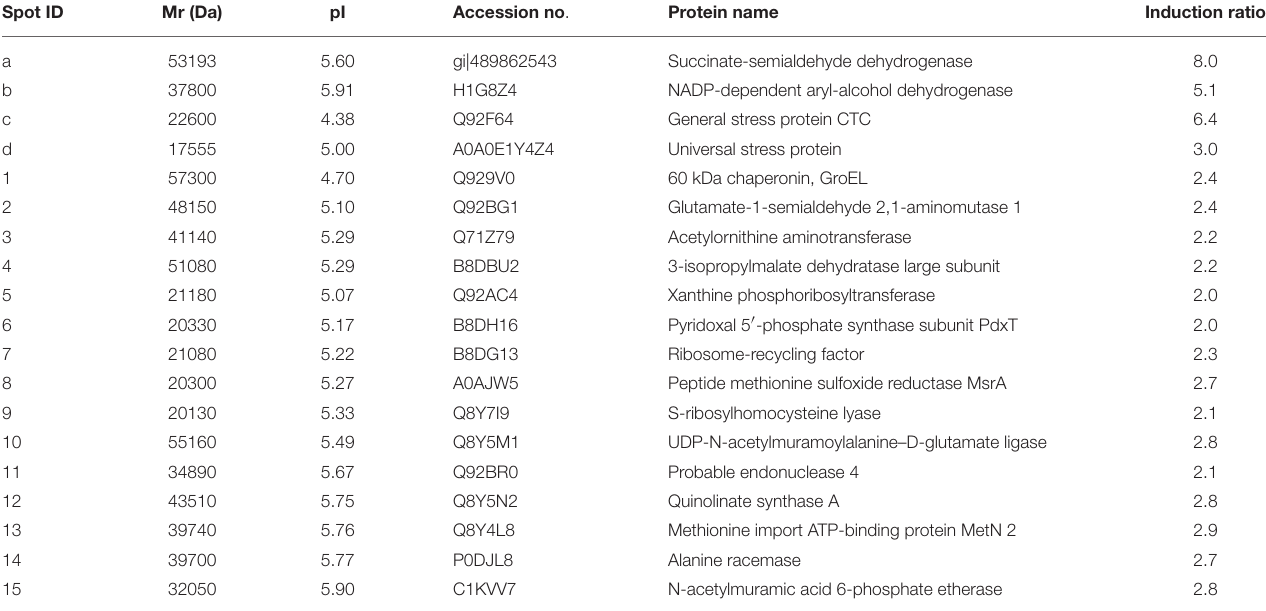
TABLE 2 | Main proteins up-regulated in L. innocua ATCC 33090 cultivated in acid stress conditions. Spot ID Mr (Da) pI Accession no . Protein name Induction